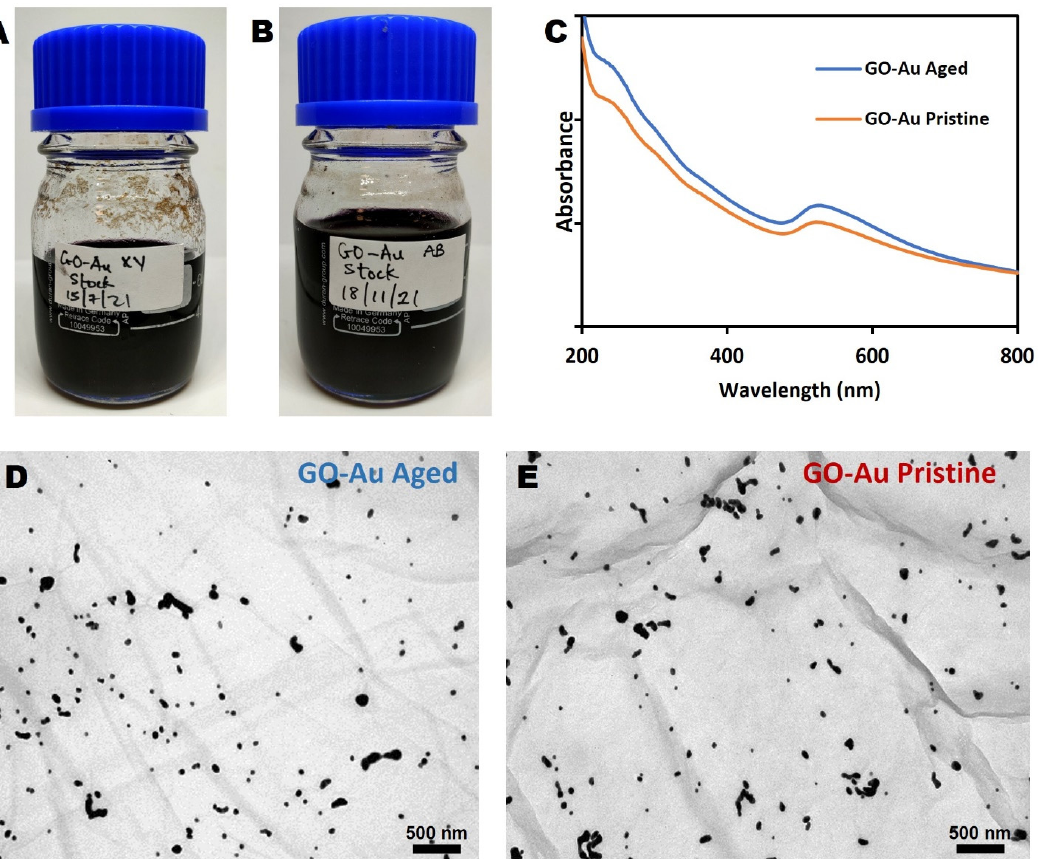
Figure 3. Characterization of pristine and aged (by 4 months) GO ‐ Au nanohybrid. ( A ) Stock of aged nanohybrid (GO ‐ AU XY), ( B ) Stock of pristine nanohybrid (GO ‐ AU XY) ( C ) UV ‐ Vis spectra of the two nanohybrids, ( D ) TEM image of GO ‐ AU Aged ( E ) TEM image of GO ‐ AU